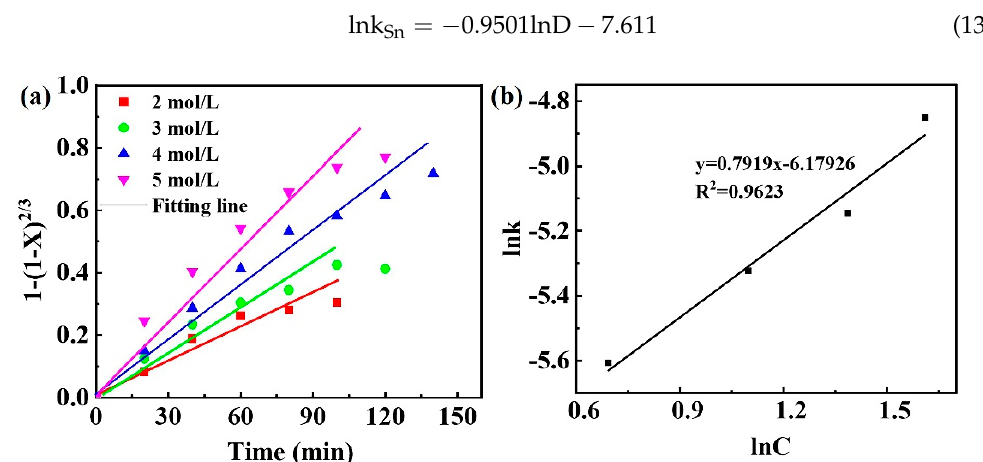
Figure 6. ( a ) Plot of [1 − (1 − X ) 2/3 ] − t for Sn at different HCl concentration and ( b ) relationship between lnk and lnC for Sn.